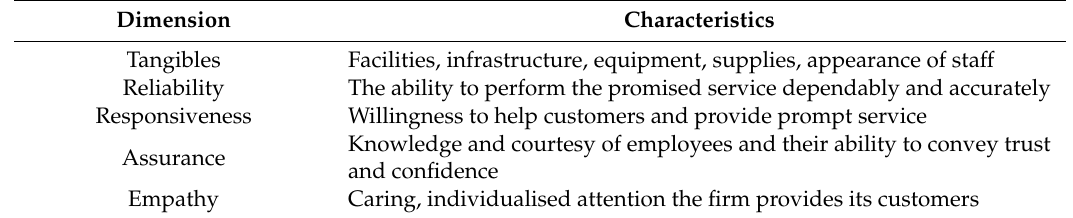
Table 2. Service quality dimensions in SERVQUAL [20].